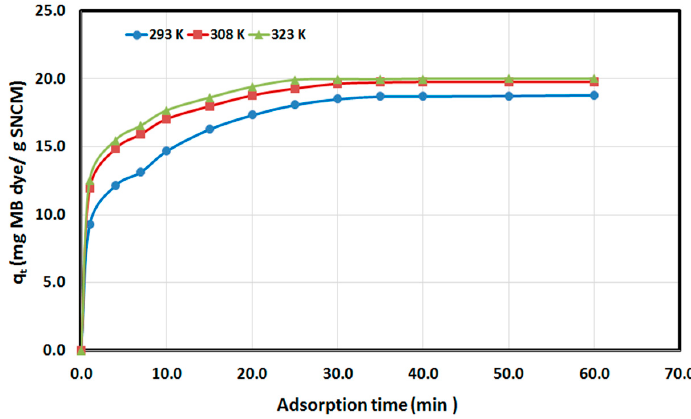
Figure 8. Variation of the amount MB dye adsorbed per unit mass of SNCM ( q t ) with time.